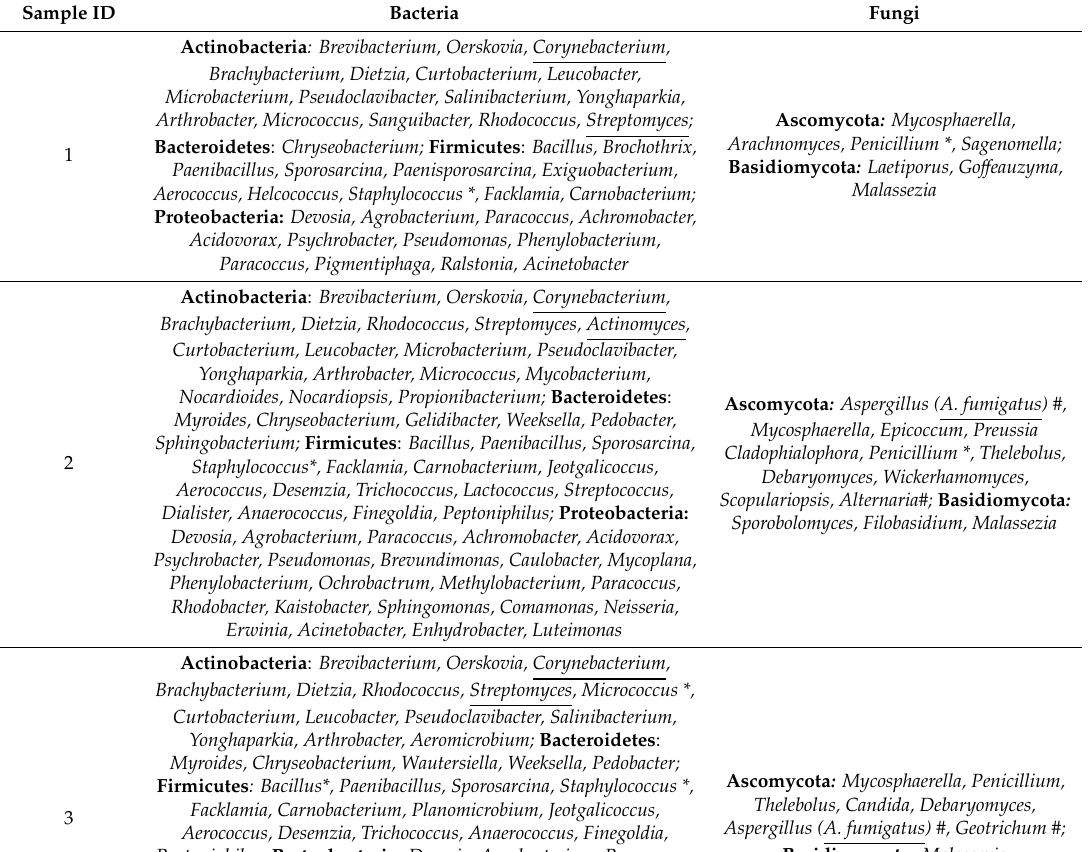
Table 4. Microorganisms identified by high-throughput sequencing and culture methods in samples acquired from feet skin of examined